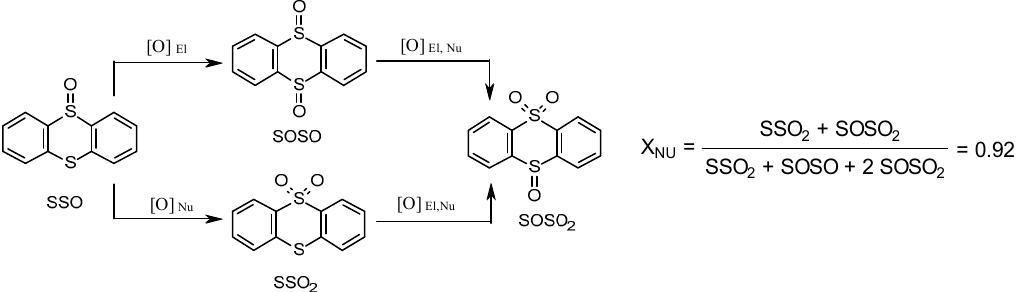
Table 2. Oxidation of methyl phenyl sulfide (MPS) with H 2 O 2 over various Zr-MOFs (adapted from refs [91,92]) and comparison with MIL-125(Ti) [93].